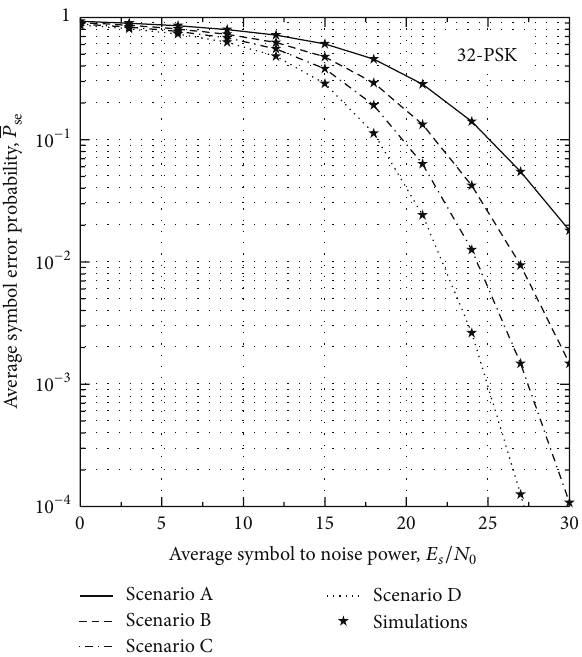
, of 32 -PSK of dual- se